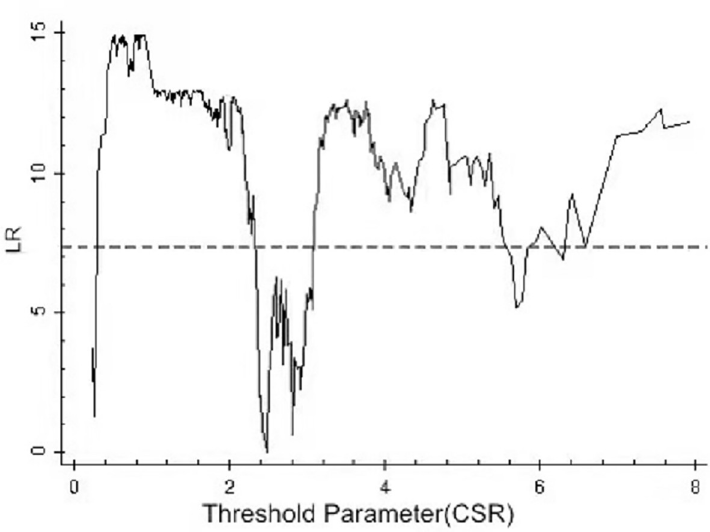
Fig 2. Estimated value and confidence interval of the second threshold in Model